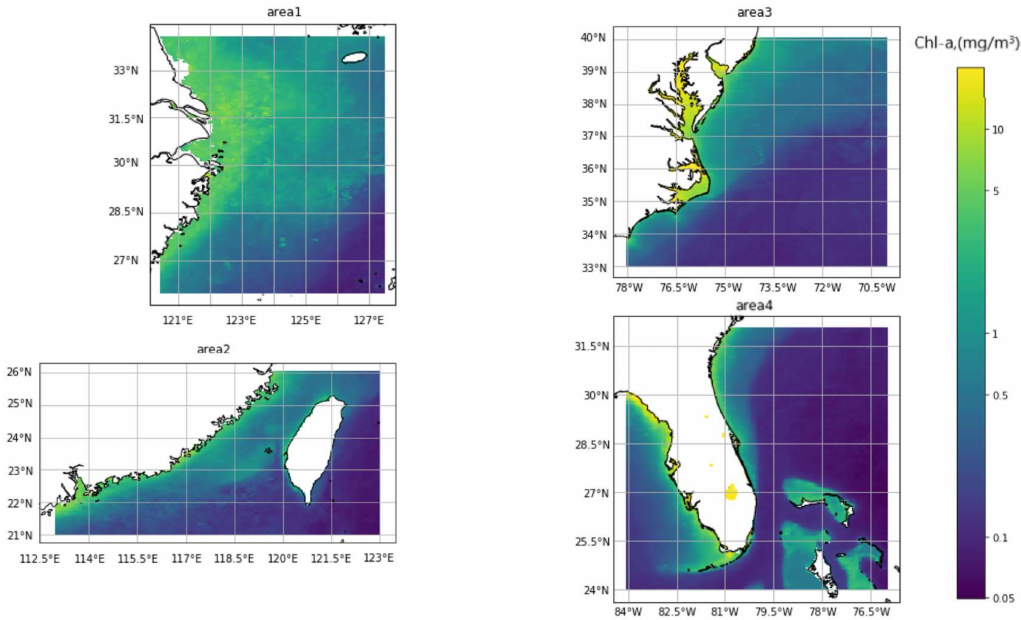
Figure 1. Averaged Chl-a concentration from 2011 to 2020 using valid